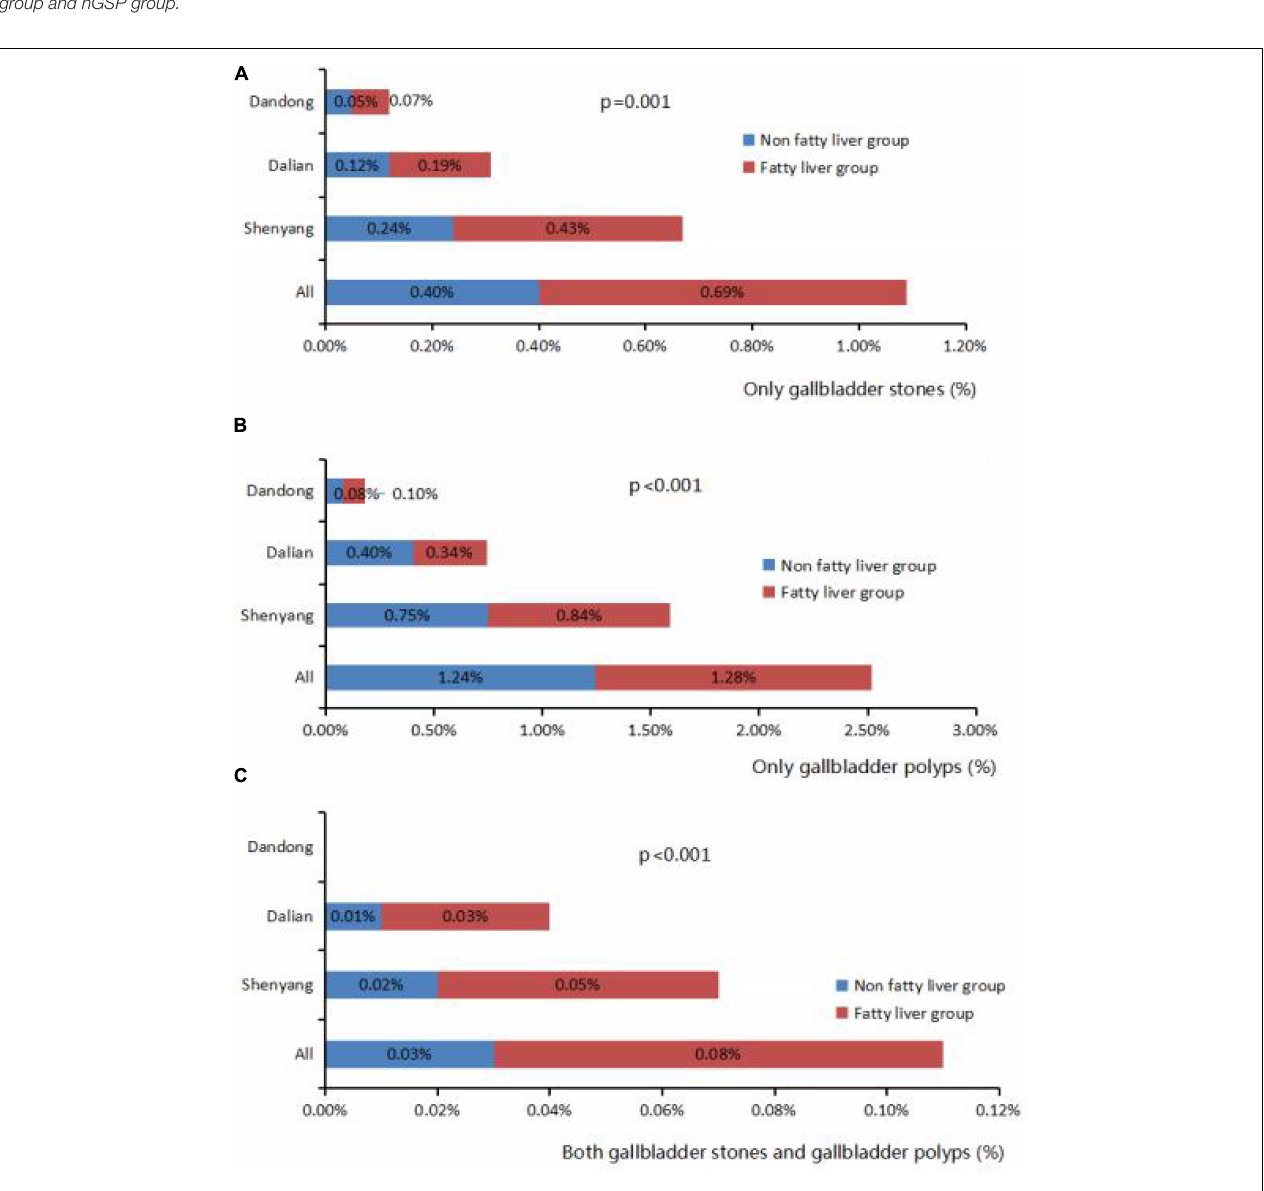
FIGURE 2 | Correlation fatty liver and gallbladder stone and gallbladder polyps. (A) The proportion of gallbladder stones in fatty liver group and non-fatty liver group in different cities. (B) The proportion of gallbladder polyps in fatty liver group and non-fatty liver group in different cities. (C) The proportion of both gallbladder stones and polyps in fatty liver group and non-fatty liver group in different